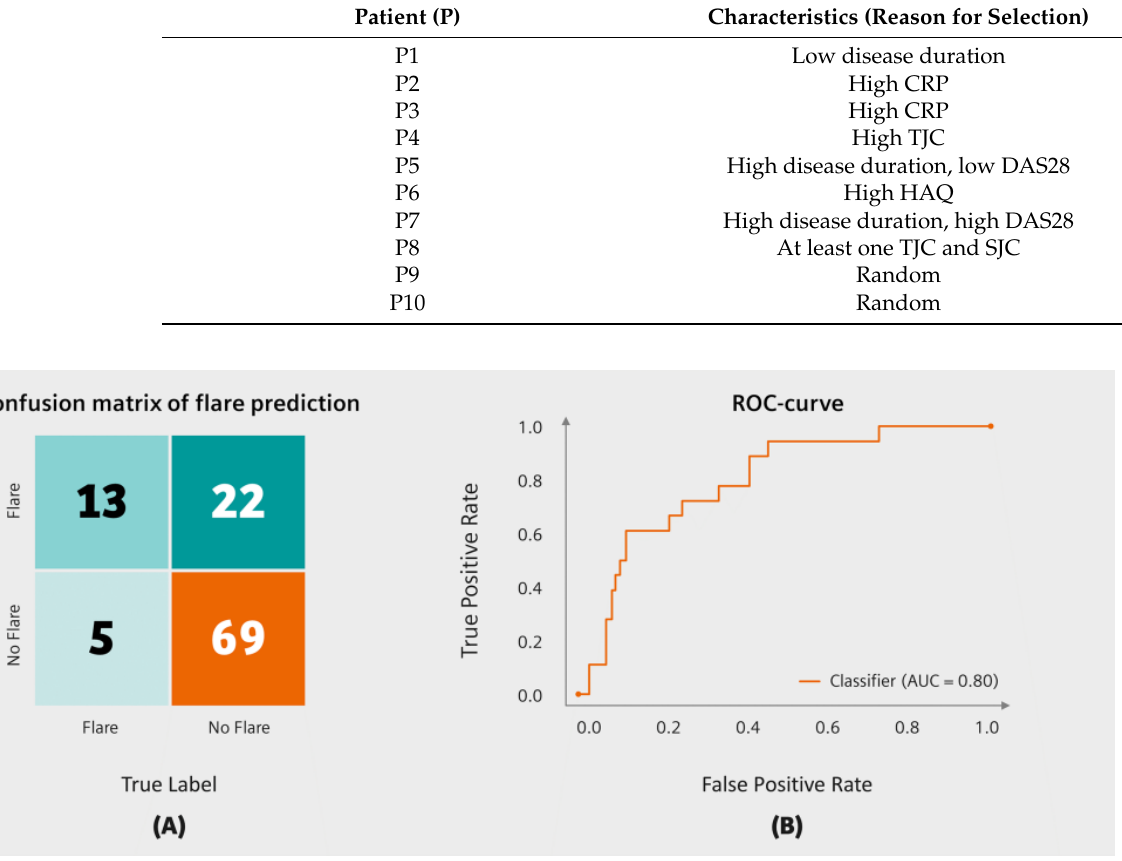
Figure 3. Flare prediction accuracy. ( A ) Confusion matrix of flare prediction and ( B ) receiver operating characteristic (ROC) curve.